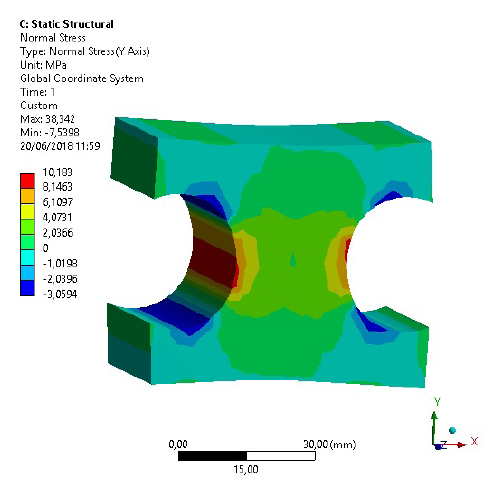
Figure 21. Normal stress distribution for 45-orientation specimens (A or B) in tension